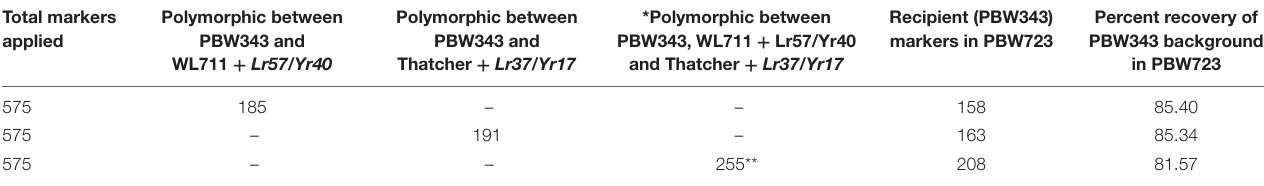
TABLE 10 | Percent background of PBW343 recovered in PBW 723.